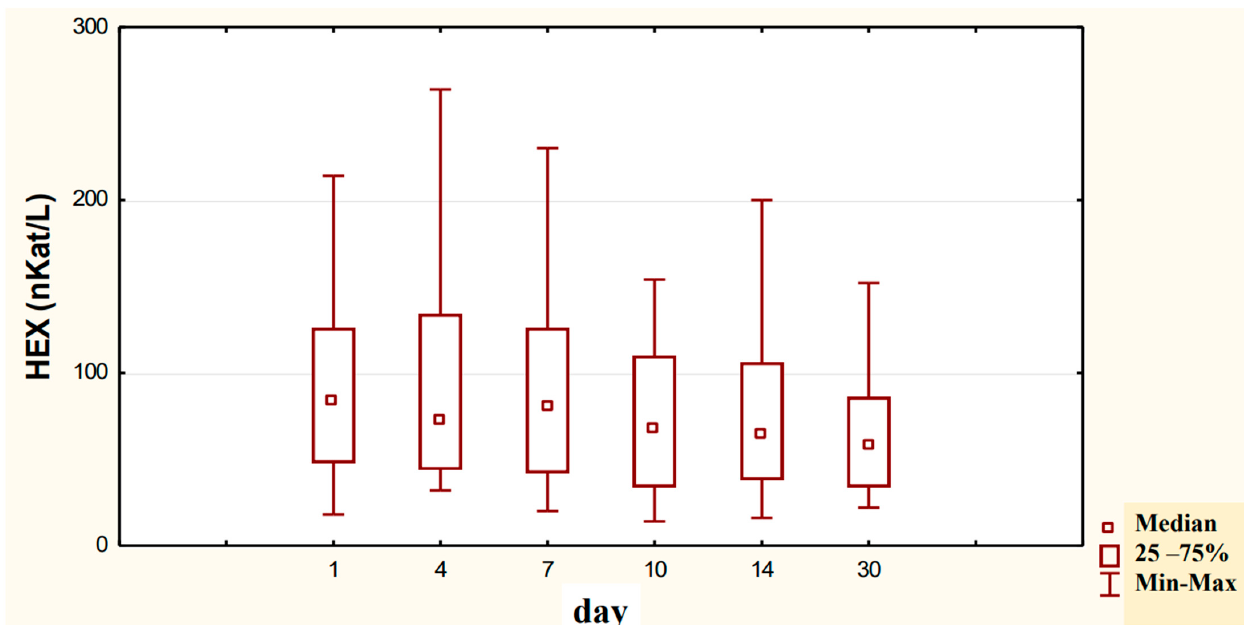
Figure 5. Variability over time in the concentration of urinary HEX activity (nKat/L) of alcohol-dependent patients treated with neoglandin (N).